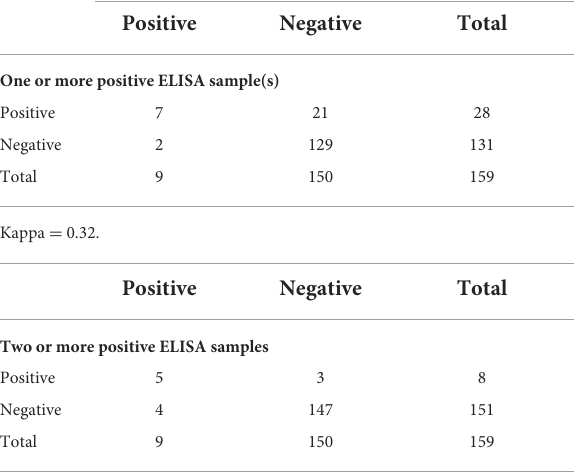
TABLE 4 Comparison of MAP testing results for herds with one or more positive fecal PCR (pool of 5 fecal samples) result compared to herds with one or more positive ELISA result and two or more positive ELISA results for 159 beef herds.